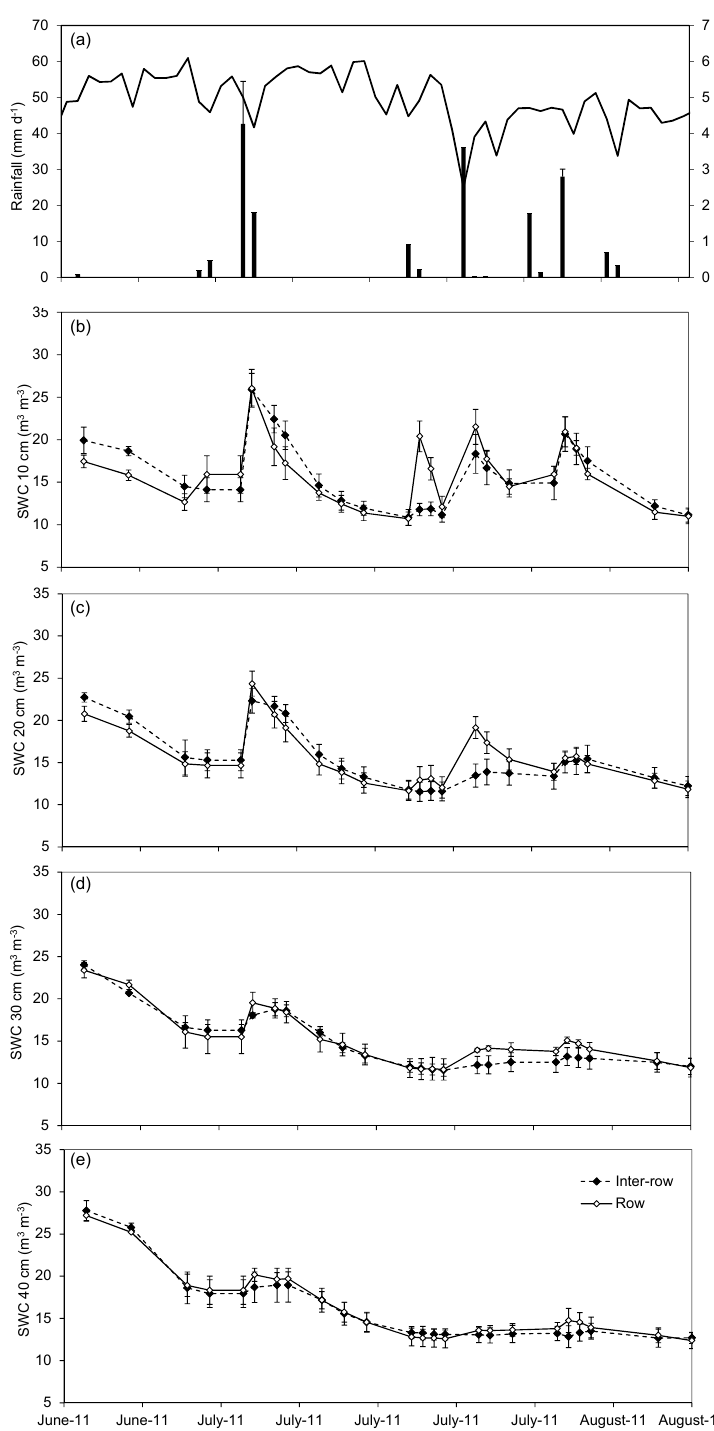
Figure 9. Daily evolution of ( a ) meteorology and profile soil water content (SWC) for: ( b ) 0 to 10 cm; ( c ) 10 to 20 cm; ( d ) 20 to 30 cm; ( e ) 30 to 40 cm. Error bars indicate standard